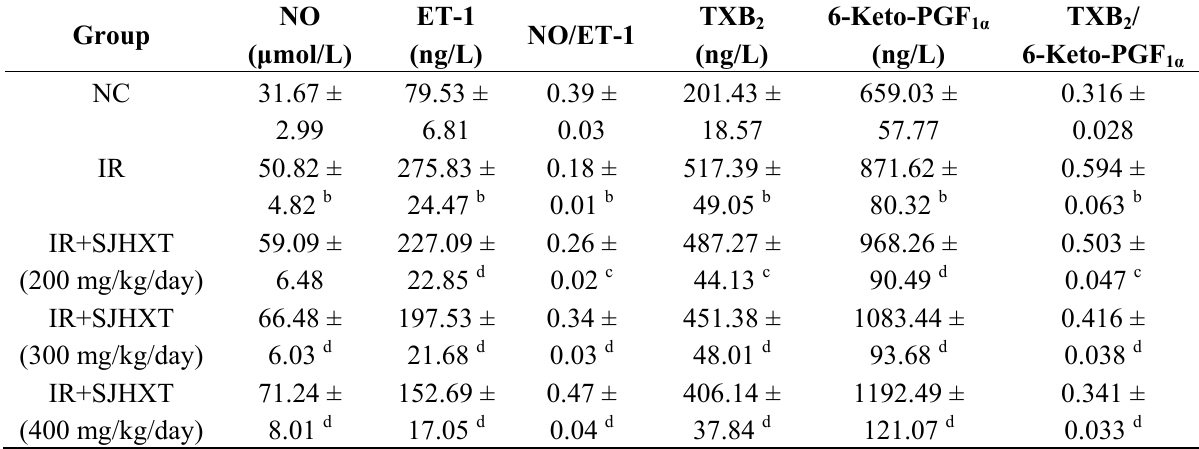
Table 1. Effect of SJHXT on serum NO, ET-1, TXB and TXB /6-Keto-PGF ratio in control and experimental 2 1 α